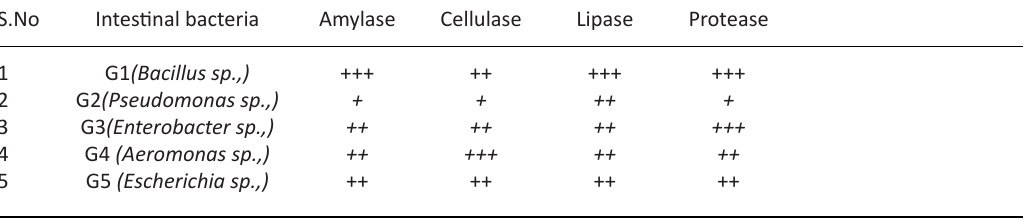
Table 4. Enzyme Productivity of Intestinal bacteria of Blue Gourami